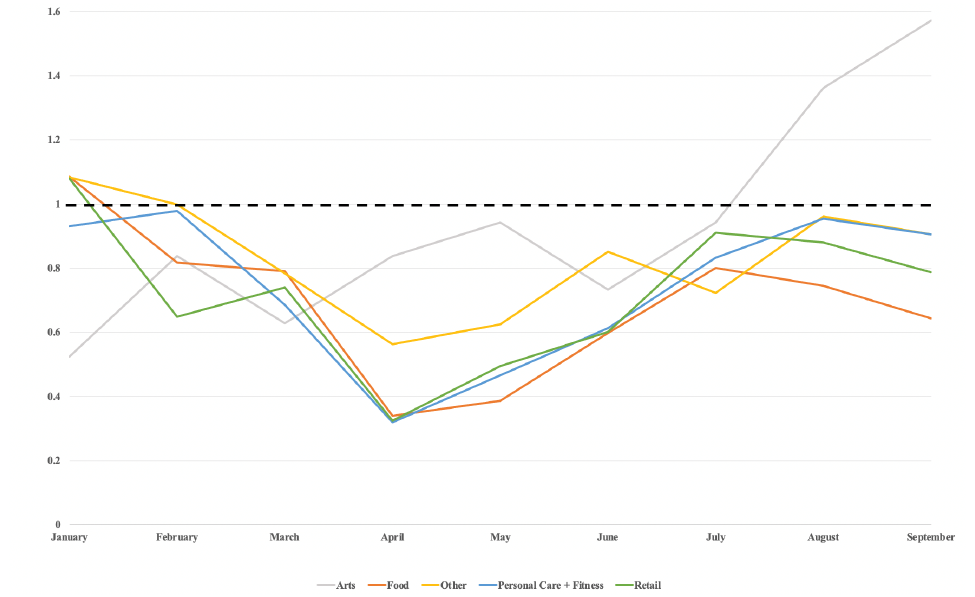
Figure 5: Percent difference in new starts between each month in 2020 and the average number of monthly new starts from January 2016 - December 2019 for independent establishments